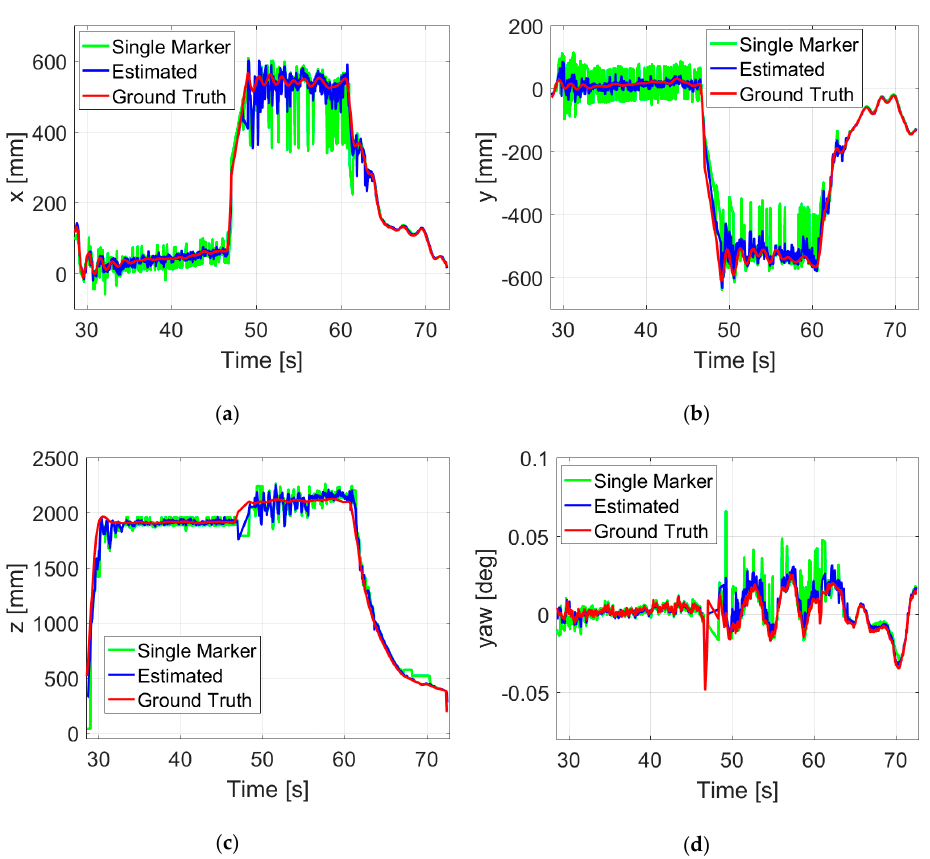
Figure 14. Position ( a,b,c ) and yaw angle ( d ) estimates during an indoor autonomous takeoff, hovering, and landing flight.